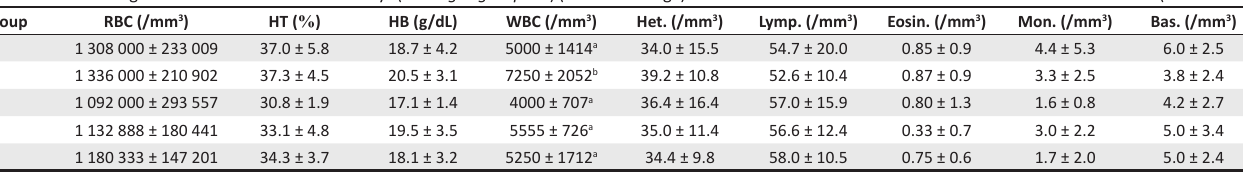
TABLE 7: Haematological values in female bronze turkeys ( Meleagris gallopavo ) (52 weeks of age) vaccinated with various commercial strains of Newcastle disease (mean ± s.d.). Group RBC (/mm 3